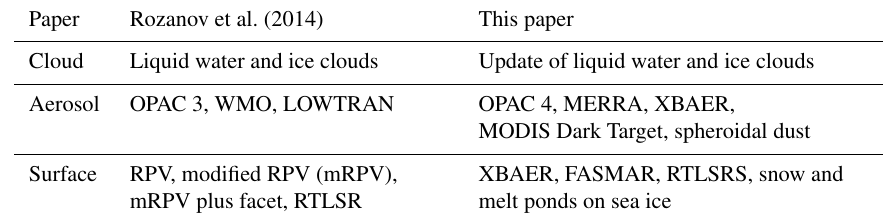
Table 1. Databases and models described in Rozanov et al. (2014) and in this paper. Paper Rozanov et al. (2014) This paper Cloud Liquid water and ice clouds Update of liquid water and ice clouds Aerosol OPAC 3, WMO, LOWTRAN OPAC 4, MERRA, XBAER, MODIS Dark Target, spheroidal dust Surface RPV, modified RPV (mRPV), mRPV plus facet, RTLSR melt ponds on sea